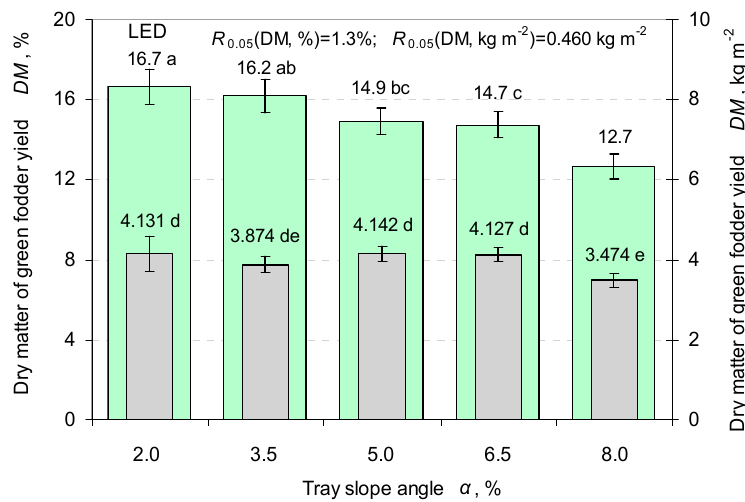
Figure 5. Influence of the slope angle of the growing tray ( α ) on the fodder dry matter after seven days of cultivation using LED lighting. Each vertical bar is 95% confidence interval. Any two samples with a common letter are not significantly different ( p < 0.05), as assessed using the least significant difference.